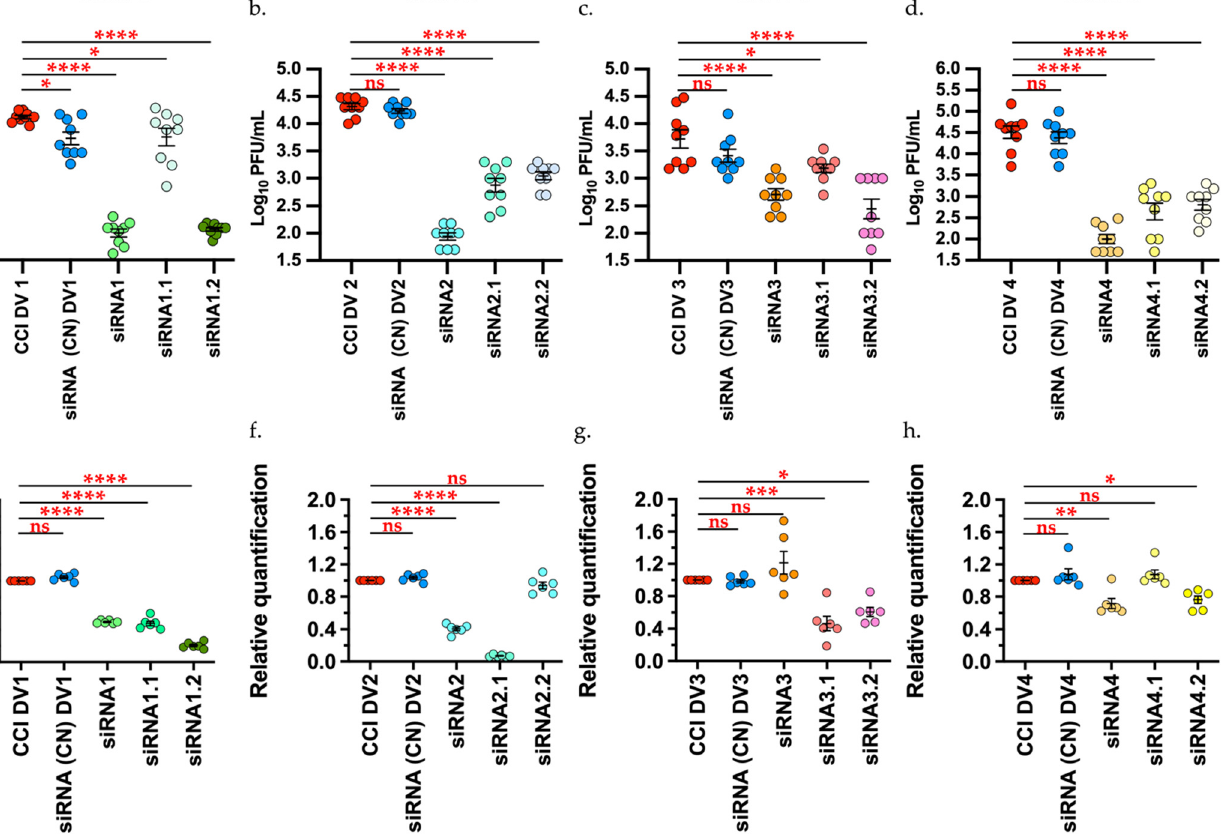
Figure 1. siRNA shows a decrease in the viral titers and relative quantification of viral genome of the DENV1–4 by plaque assay and RT-qPCR, respectively. Upper row. Effect of siRNA on the production of infectious viral particles ( a ) DENV1. ( b ) DENV2 ( c ) DENV3 ( d ) DENV4. Lower row. Expression level through relative quantification via RT-qPCR 2 − ∆∆ Ct normalized by GAPDH. ( e ) DENV1. ( f ) DENV2 ( g ) DENV3 ( h ) DENV4. Infection control (CCI), Negative control (CN) Tukey’s multiple comparisons test * p < 0.05 ** p < 0.001 *** p < 0.0001 **** p < 0.00001. Graphic and analysis constructed in GraphPad-Prism 9.